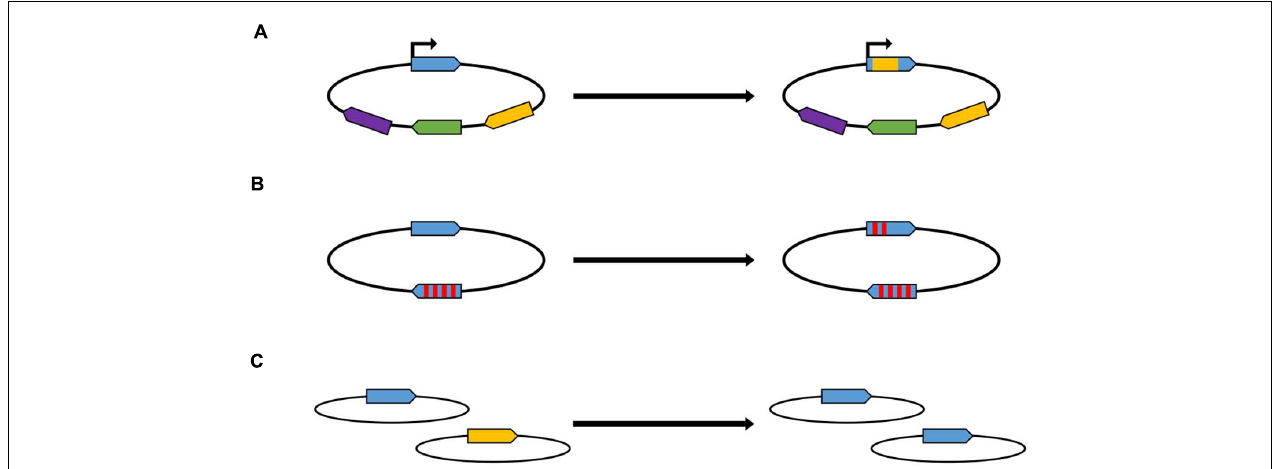
FIGURE 1 | Schematic overview of gene conversion within different biological processes. (A) Antigenic variation. The promoter of the allele in the expression site is indicated with an arrow. The different colors indicate homologous, but not identical alleles. (B) Concerted evolution of gene families. Two members of a gene family are shown schematically, the red stripes indicate single nucleotide differences between the two genes. (C) Equalization of genomes in polyploid prokaryotes. Two genomes are shown schematically, which contain at identical sites two slightly different versions of the same